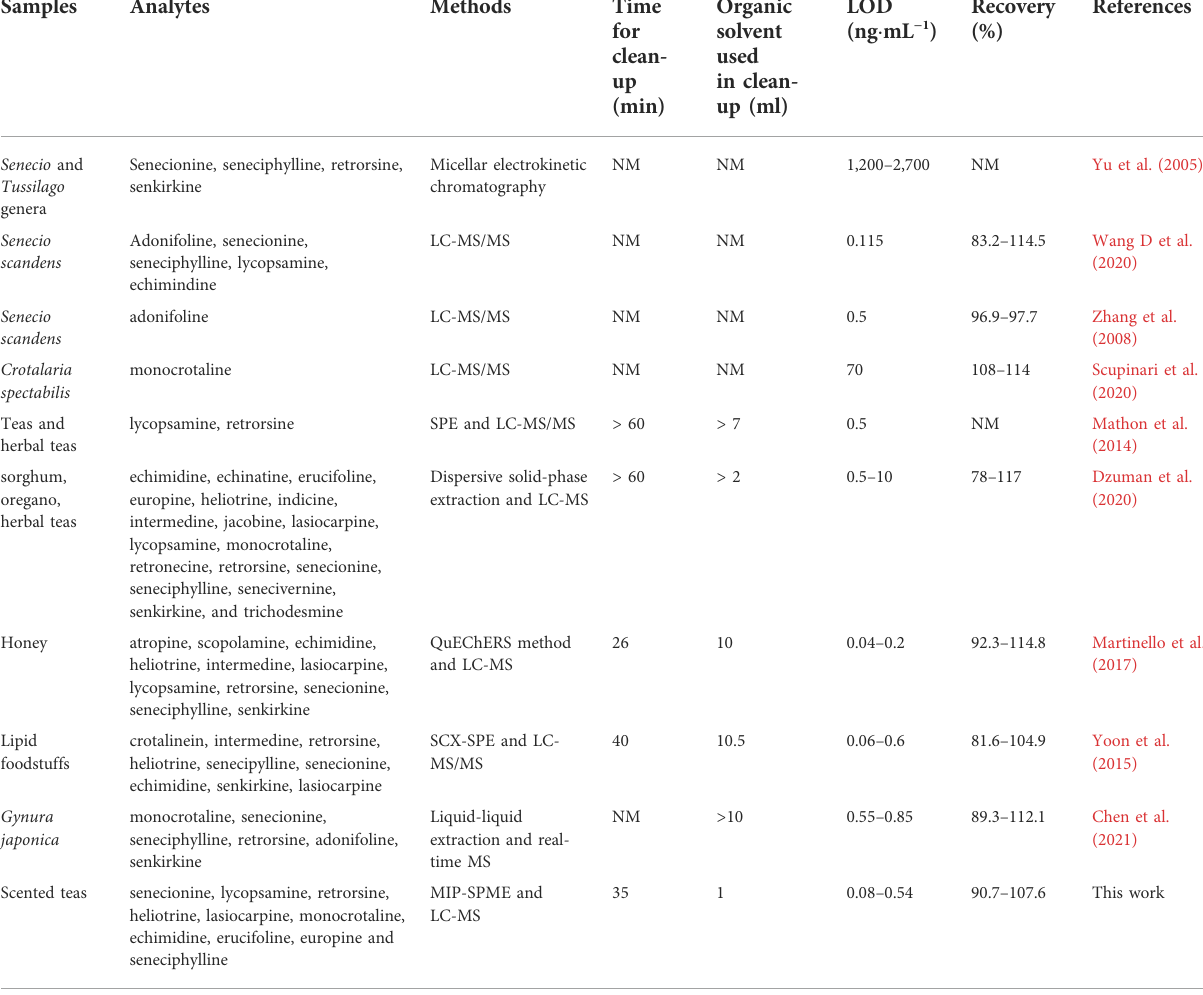
TABLE 6 Comparison of different methods for detection of PAs in different samples.